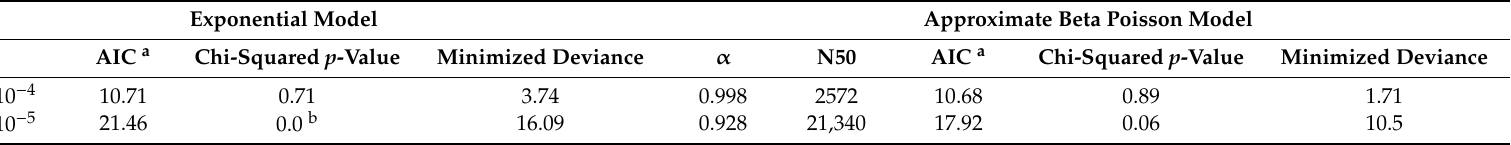
Table 4. Comparison of goodness of fit for the determination of best-fitting ID50 and DD50 model for